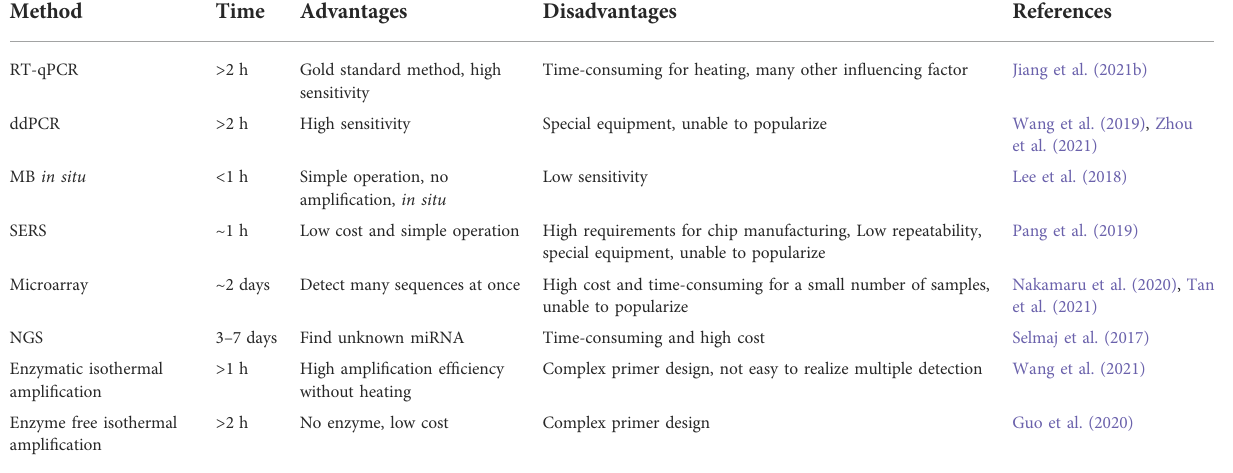
TABLE 2 Summary of EV-derived miRNA detection